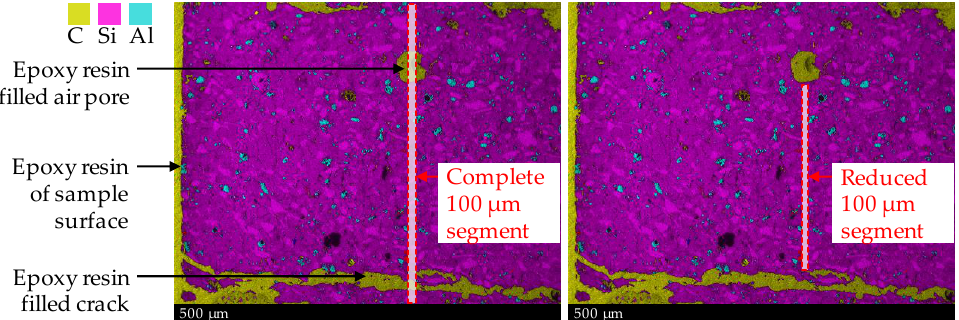
Figure 3. SEM-EDX mapping image of corroded geopolymer specimen. Illustration of complete 100 µm segment (including epoxy resin-filled air pores and cracks) and reduced 100 µm segment, to avoid the influence of epoxy resin and cracks on the mole fractions of elements.